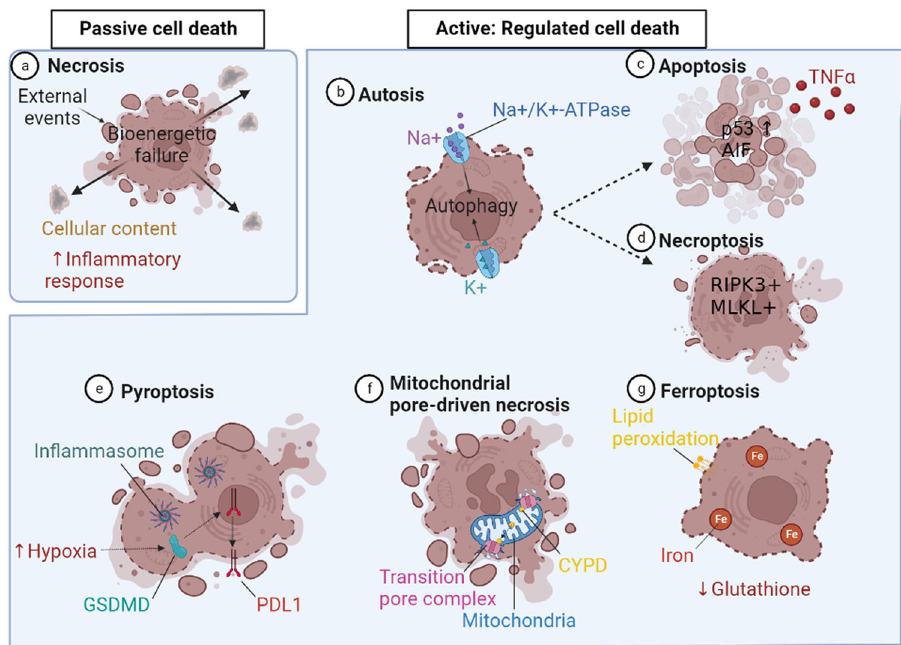
Fig. 1 Types of cell death. Passive cell death; a Necrosis is a form of death where external events induce bioenergetic failure and plasma membrane breakdown, promoting the cellular contents to be released into the extracellular space, inducing an in fl ammatory response. Active: Regulated cell death; b Autosis is a form of excess autophagy mediated via Na + /K + -ATPase, which results in swelling and plasma membrane breakdown. c Apoptosis is regulated by the transcription factor p53 and is triggered by in fl ammatory mediators such as TNF α that activate the apoptosis-inducing factor mitochondria associated 1 (AIF). d Necroptosis is a form of controlled necrosis activated by death receptors like Toll-like and TNF receptor-1 (TNFR1) that act on RIPK1 and activate necroptosome forming elements, RIPK3 and MLKL. e Pyropotosis is a form of controlled cell death mediated by in fl ammasome activation, and triggered by hypoxia, activating gasderminD (GSDMD) leading to nuclear translocation of the programmed death ligand 1 (PDL1). f Mitochondrial permeability transition-driven necrosis is activated by metabolic stress which in fl uences the opening of the permeability transition pore complex at the inner and outer mitochondrial membranes driven by the binding of cyclophilin D (CYPD). g Ferroptosis if a form of cell death that takes place under glutathione de fi ciency and induces an increase in cellular iron, altering the intracellular environment and causing lipid peroxidation. Created using